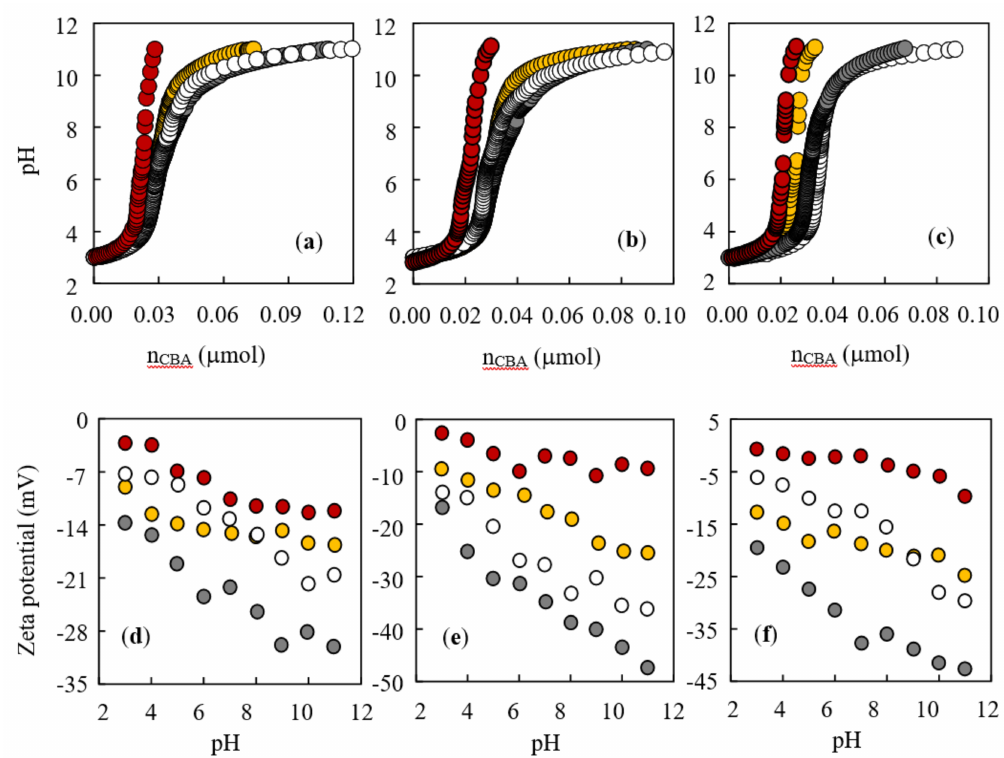
Figure 3. Titration of acidic groups ( a , b , c ) and Zeta potential ( d , e , f ) of biochars at 250, 350 and 450 ◦ C, respectively. The grey, yellow, white, and red symbols referred to BA-, PS-, CE-, and LI-derived biochars,